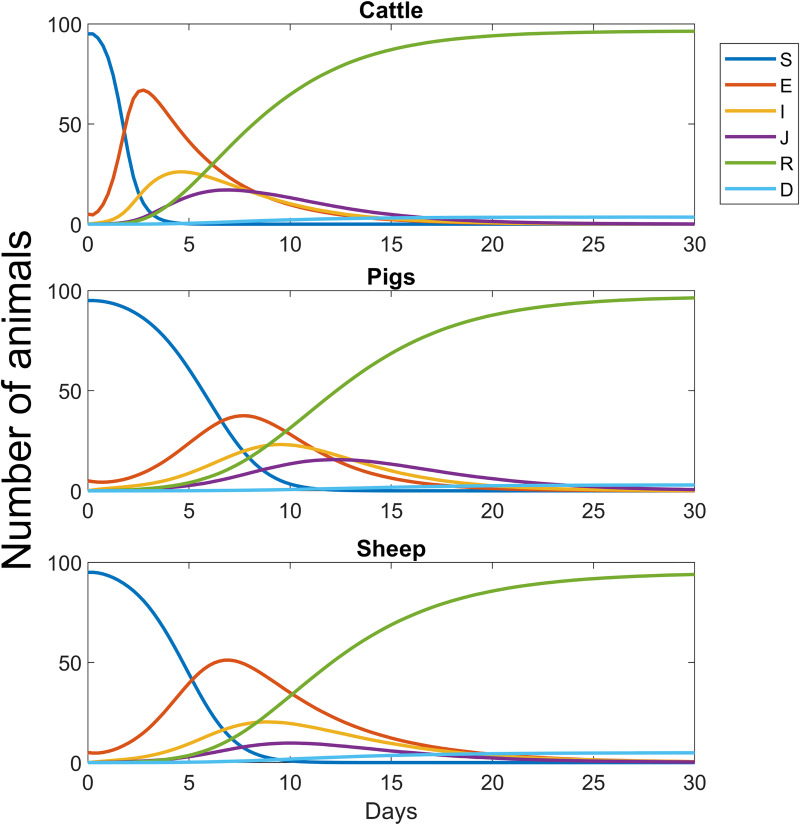
The development of FMD amongst the animals on an infected farm, i.e. intrafarm disease spread.The disease is initiated with 5 infected and 95 uninfected animals in all cases. The disease develop quickest in the case with cattle and slowest for pigs.